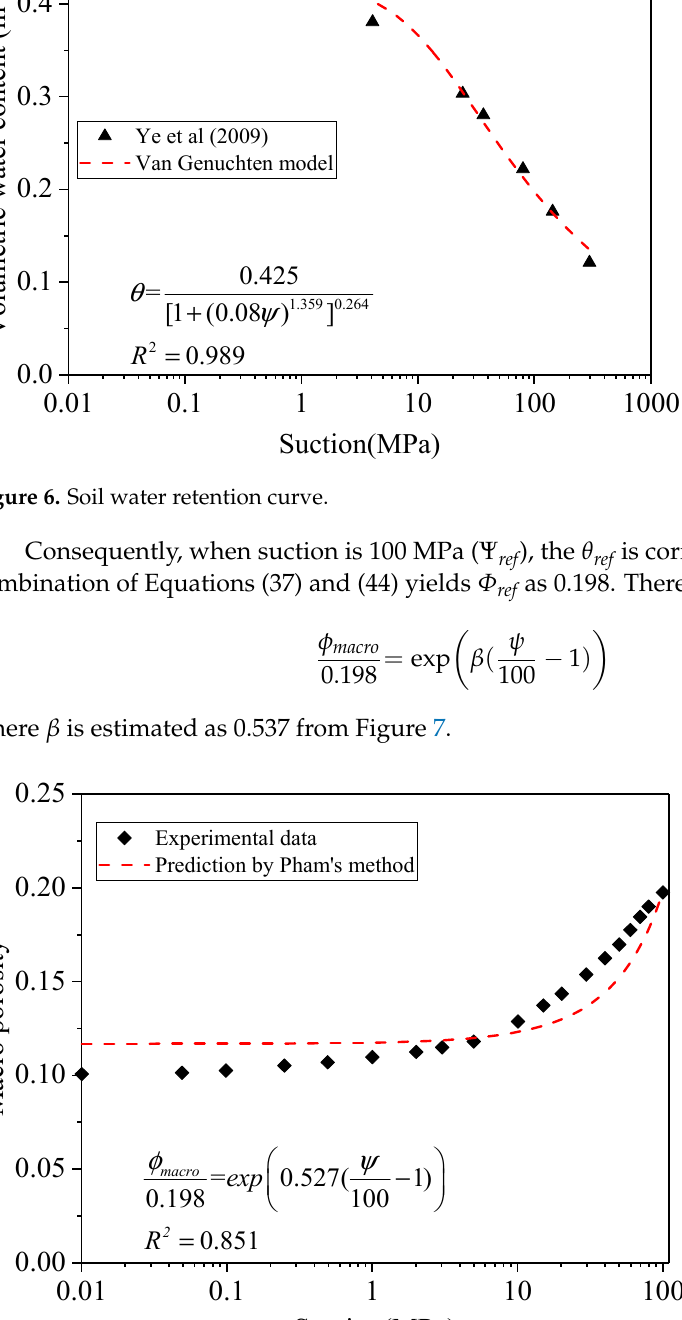
Figure 7. Relationship between macro porosity and suction.